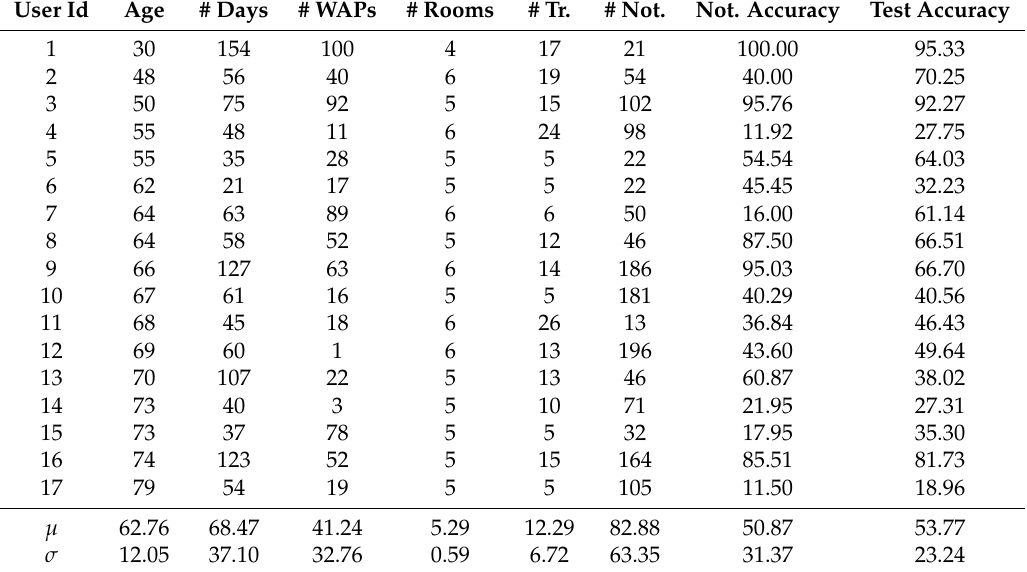
Table 1. For each user, each row shows the ID, his/her age, the number of WAPs that can be perceived in their homes, the number of rooms trained, the total number training session performed, and the number of answered notifications. # stands for number of . The last two columns show both ways of estimating the accuracy of the IPS (see accuracy definitions at Section